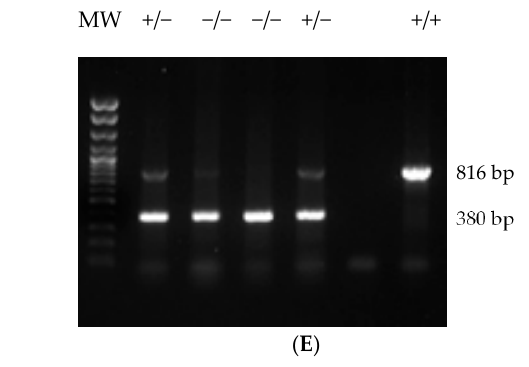
Figure 4. Diagrams of Cnr1 f/f ( A ) Cnr2 f/f ( B ) alleles. Open boxes represent exons and Neo-footprint, gray boxes open reading frames of Cnr1 and Cnr2, solid line introns and genomic flanking regions, triangle lines alternative splicing patterns, numbers base pairs (bp), black forward arrowheads loxP sites, and black ovals remnant FRT sites in Neo-footprint, solid bars RNAscope ISH probes, and upward arrows polyA sites. ( C ) Validation of CB1R-specific deletion in Alb-Cnr1 Δ hepatocytes by preAmp-RT-qPCR; Q represents QuantaBio preamp and real-time PCR mixes and T Thermo Fisher preamp and real-time PCR mixes. ( D ) Agarose gel of Cnr2 floxed mice: mutant is 545 bp, wild type 386 bp, and the heterozygous 545 bp and 386 bp. ( E ) Agarose gel of Cx3cr1-Cre mice: mutant is 380 bp, wild type 816 bp, and the heterozygous 380 bp and 816 bp. MW represents the molecular weight marker.